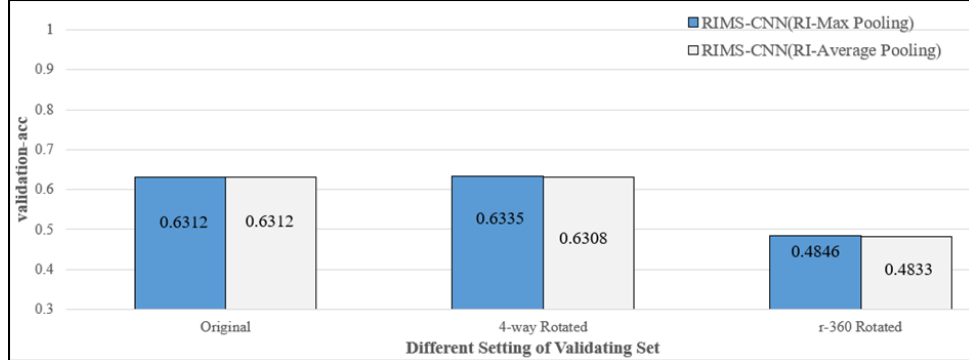
Figure 23. Comparing RI-max pooling with RI-average pooling in the different CIFAR-100 settings.